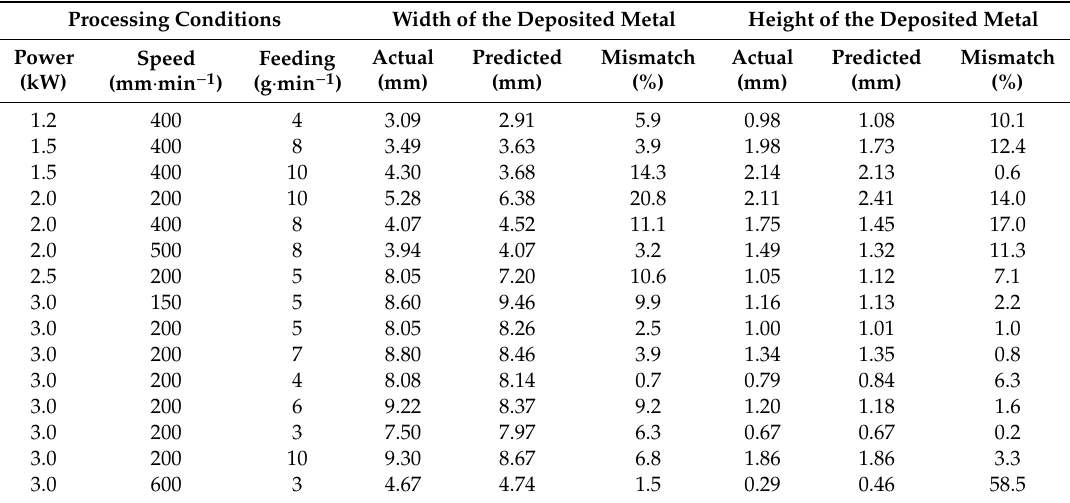
Table 2. Actual and simulated responses with absolute percentage mismatch for each processing condition, to calibrate the regression model.